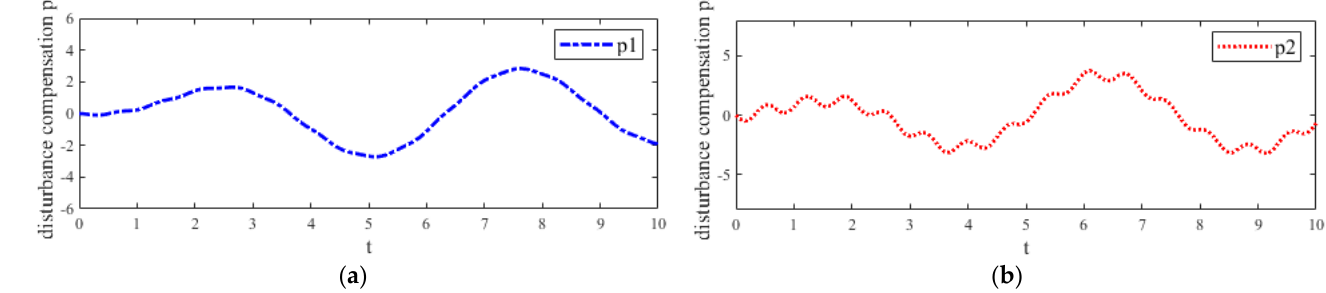
Figure 4. RBF neural network compensation results: ( a ) compensation results of p 1 ; ( b ) compensation results of p 2 .